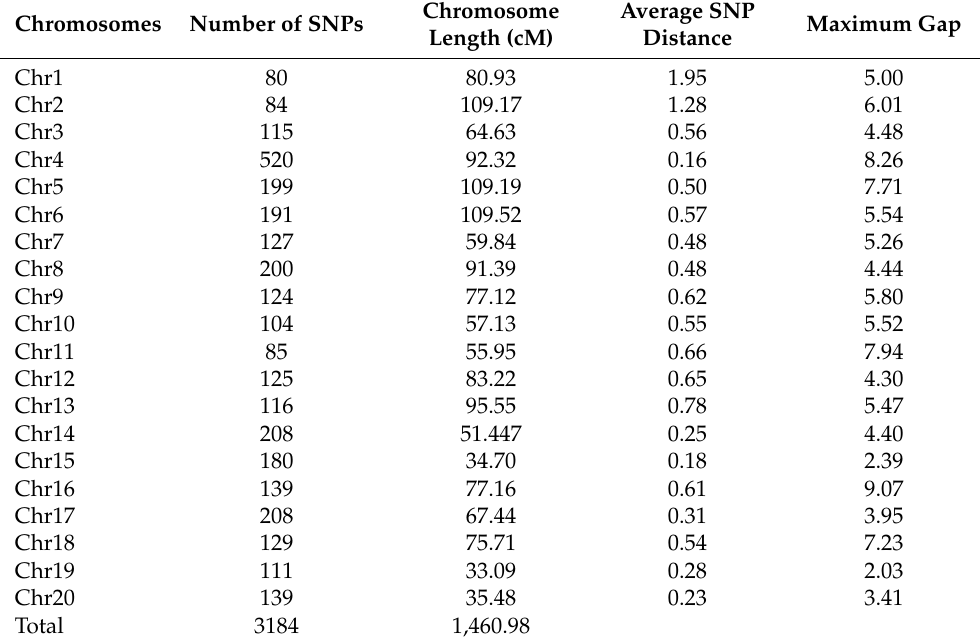
Table 2. Distribution of SNP markers and linkage group length (cM) in each chromosome.